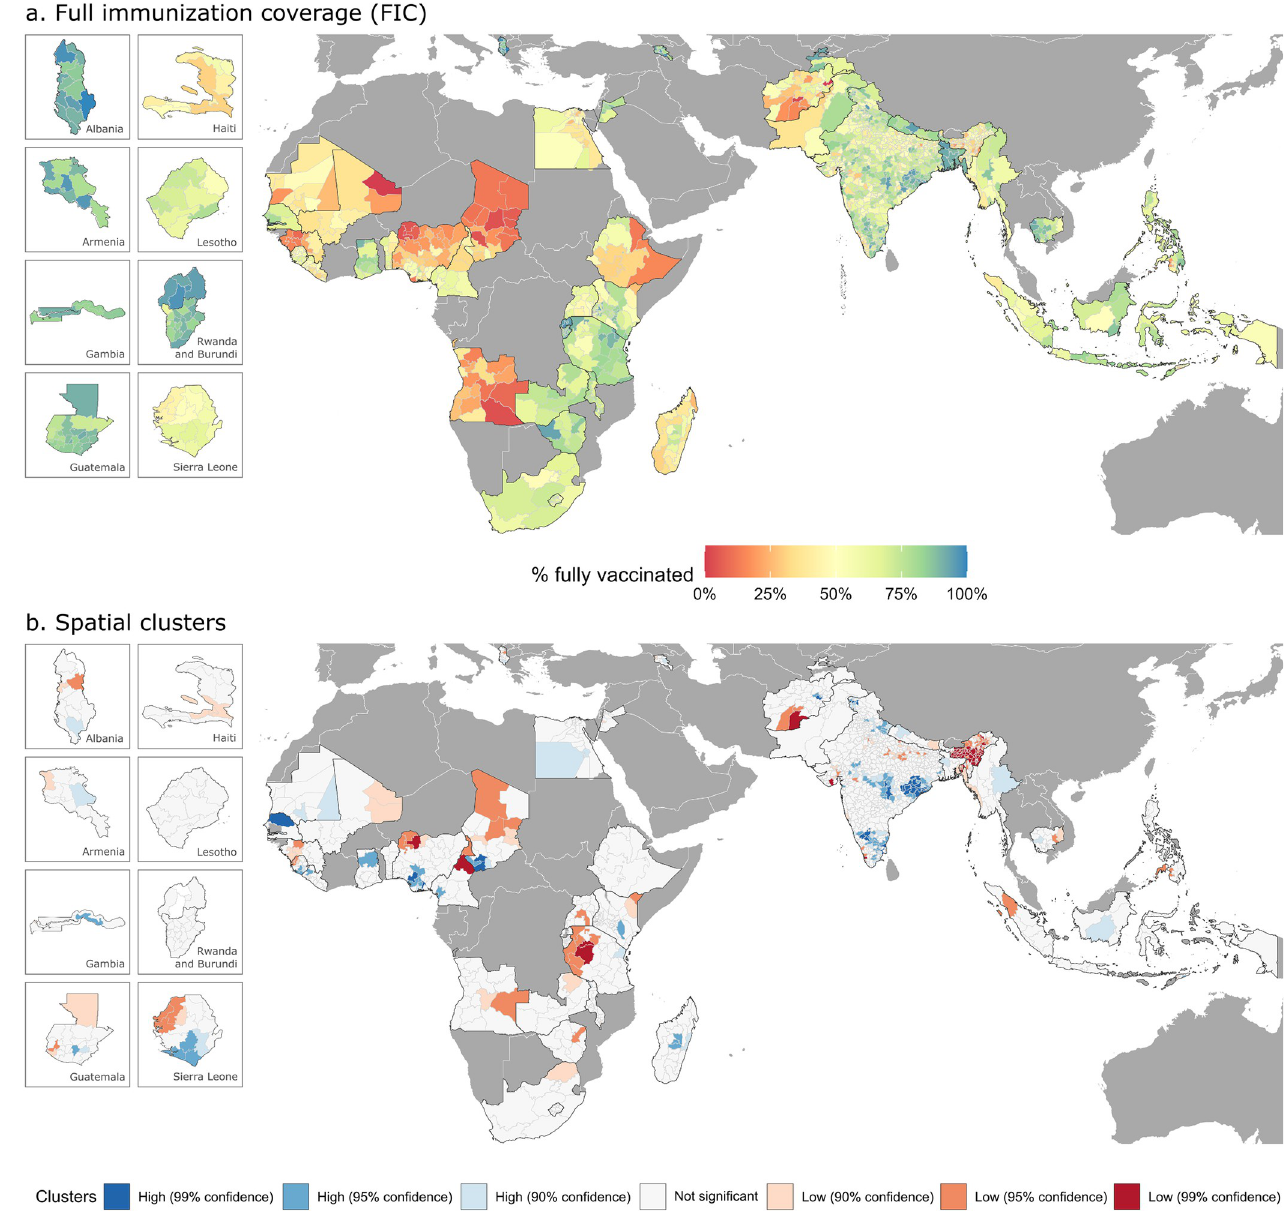
Fig 1. AU : AbbreviationlistshavebeencompiledforthoseusedinFig 1 andTables 1 and 2 : Pleaseverifythatallentriesarecorrect : Subnational estimates of FIC (a) and spatial clusters of administrative regions with high (blue colors) and low (red colors) values of FIC (b). Spatial boundaries were retrieved from Natural Earth (https://www.naturalearthdata.com/) using the “rnaturalearth” package (https://github.com/ropenscilabs/ rnaturalearth). FIC, full immunization